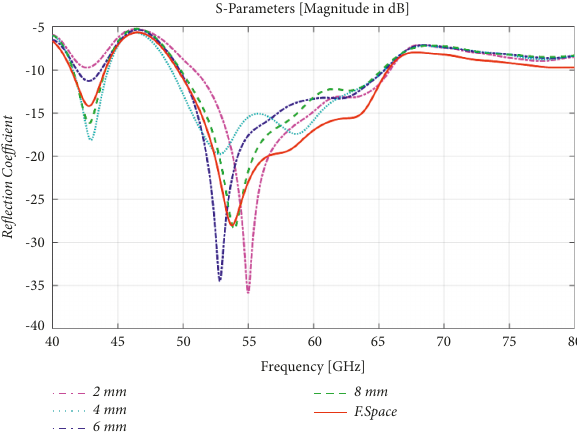
Figure 44: Return loss comparison of the 1 × 4 array antenna for different distances.